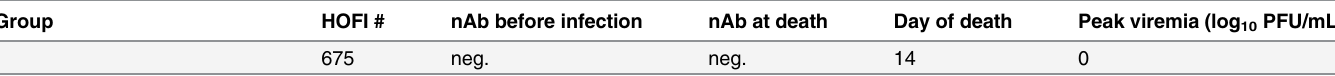
All HOFI sera were tested for nAb at a 1:20 dilution before infection and at the time of death with the end of the project at 14 dpi. Neutralization of > 90% of 50 – 90 PFU was considered positive using a plaque reduction neutralization assay (PRNT 90 ). Peak viremia titers determined by plaque assay titration are shown as log 10 PFU/mL and occurred on 3 dpi or 4 dpi.